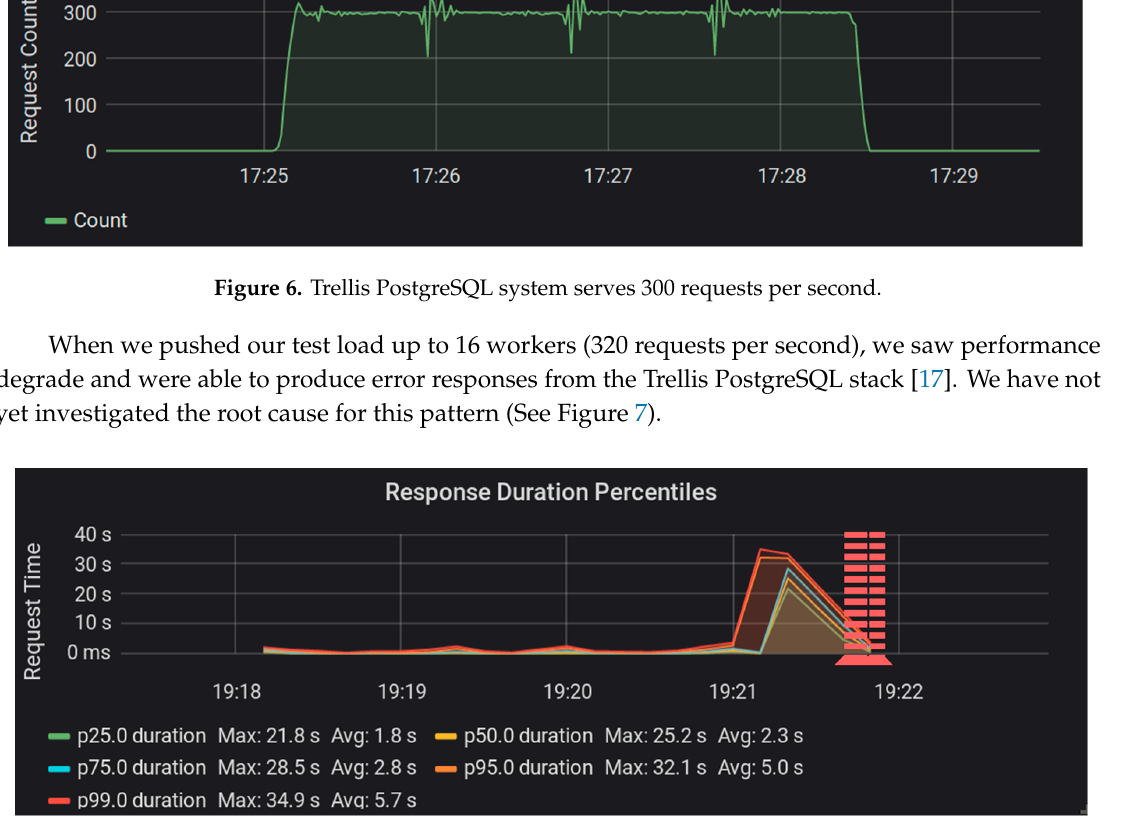
Figure 8. Trellis Cassandra (four and four) system performs at 480 requests per second. Figure 9. Trellis Cassandra (four and four) response duration percentiles at 480 RPS. We found the limit of this four Trellis, four Cassandra system when we ran 28 test workers demanding 560 requests per second [19]. At that rate, we started to see error responses as the system failed to keep up with the request load (See Figures 10 and 11). The candidate system stopped waiting for Cassandra connections that were busy processing other requests, resulting in error responses to the LDP client. This is probably a typical failure mode for a Trellis Cassandra system when subjected to too much load. It can be avoided by tuning the Cassandra timeout settings or by adding more Cassandra nodes to the cluster.